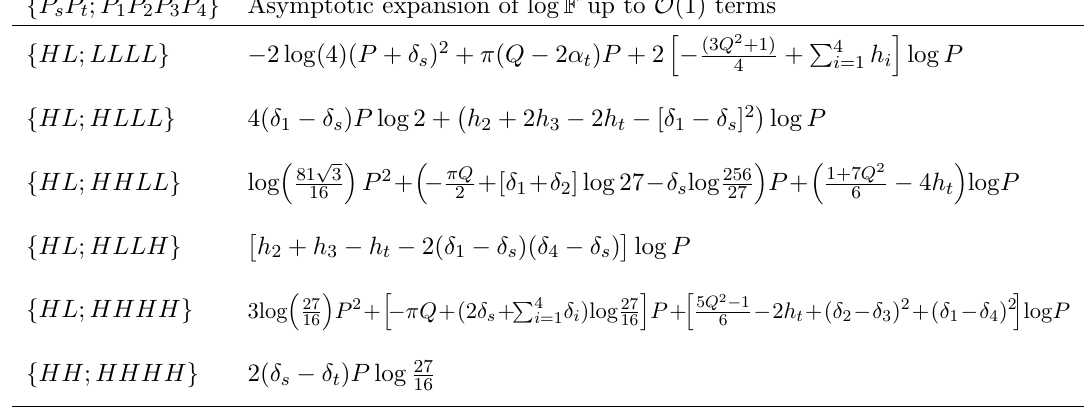
Table 2 . Asymptotic formulas for the logarithm of the Virasoro fusion kernel F P O (1) terms in the limit of large momenta with fixed differences. In the table, the label H means that the corresponding momenta P i is heavy, P i − δ i = P → ∞ , while the L variables and δ i remain